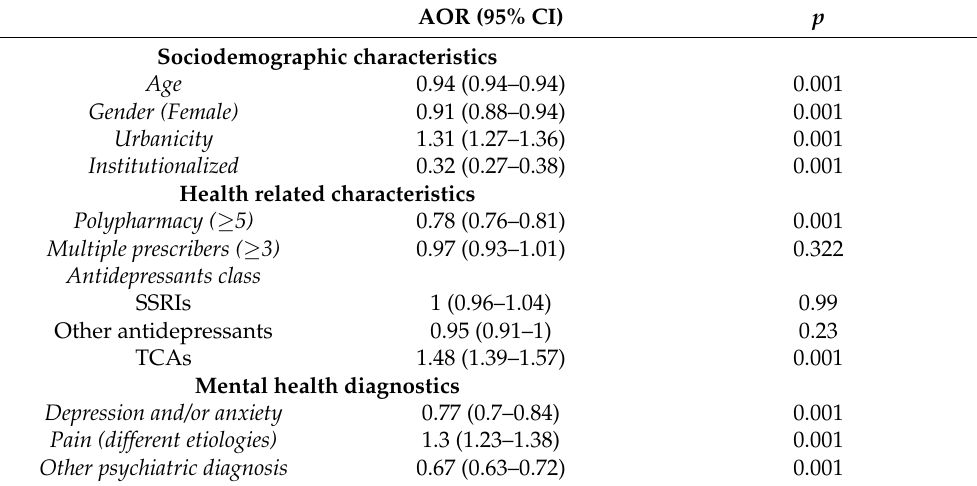
Table 3. Risk Factors for non-adherence to antidepressants among the Castile and Leon (Spain) population during